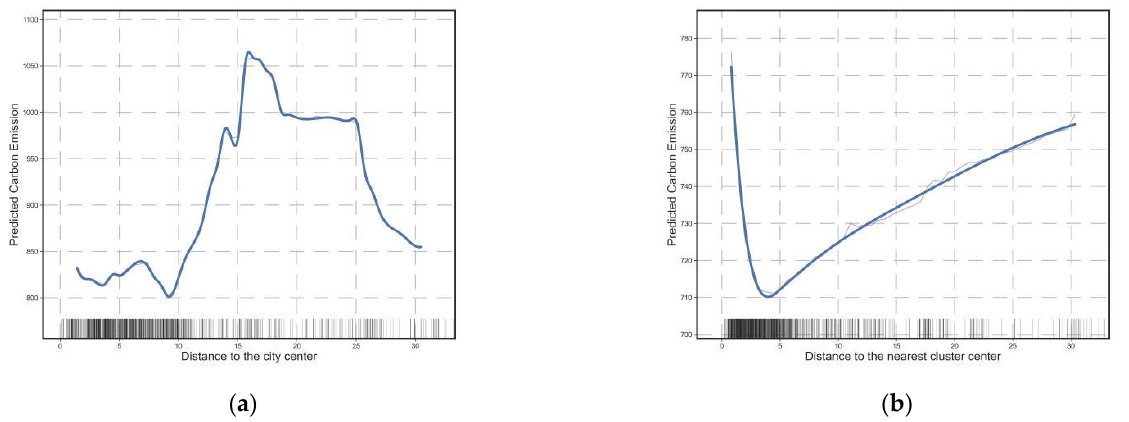
Figure 4. Influence of residential location on commuting CO 2 . ( a ) The relationship between the distance to the city center and commuting CO 2 ; ( b ) The relationship between the distance to the nearest cluster center and commuting CO 2.